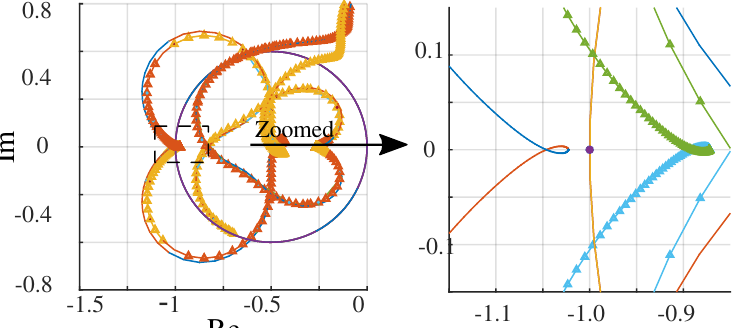
Figure 12. Eigenloci of an interconnected system where the error indicator J 2 = 0.2072. Line with triangles: eigenloci calculated according to the accurate aggregated model. Line without triangles: eigenloci calculated according to the direct aggregated model.